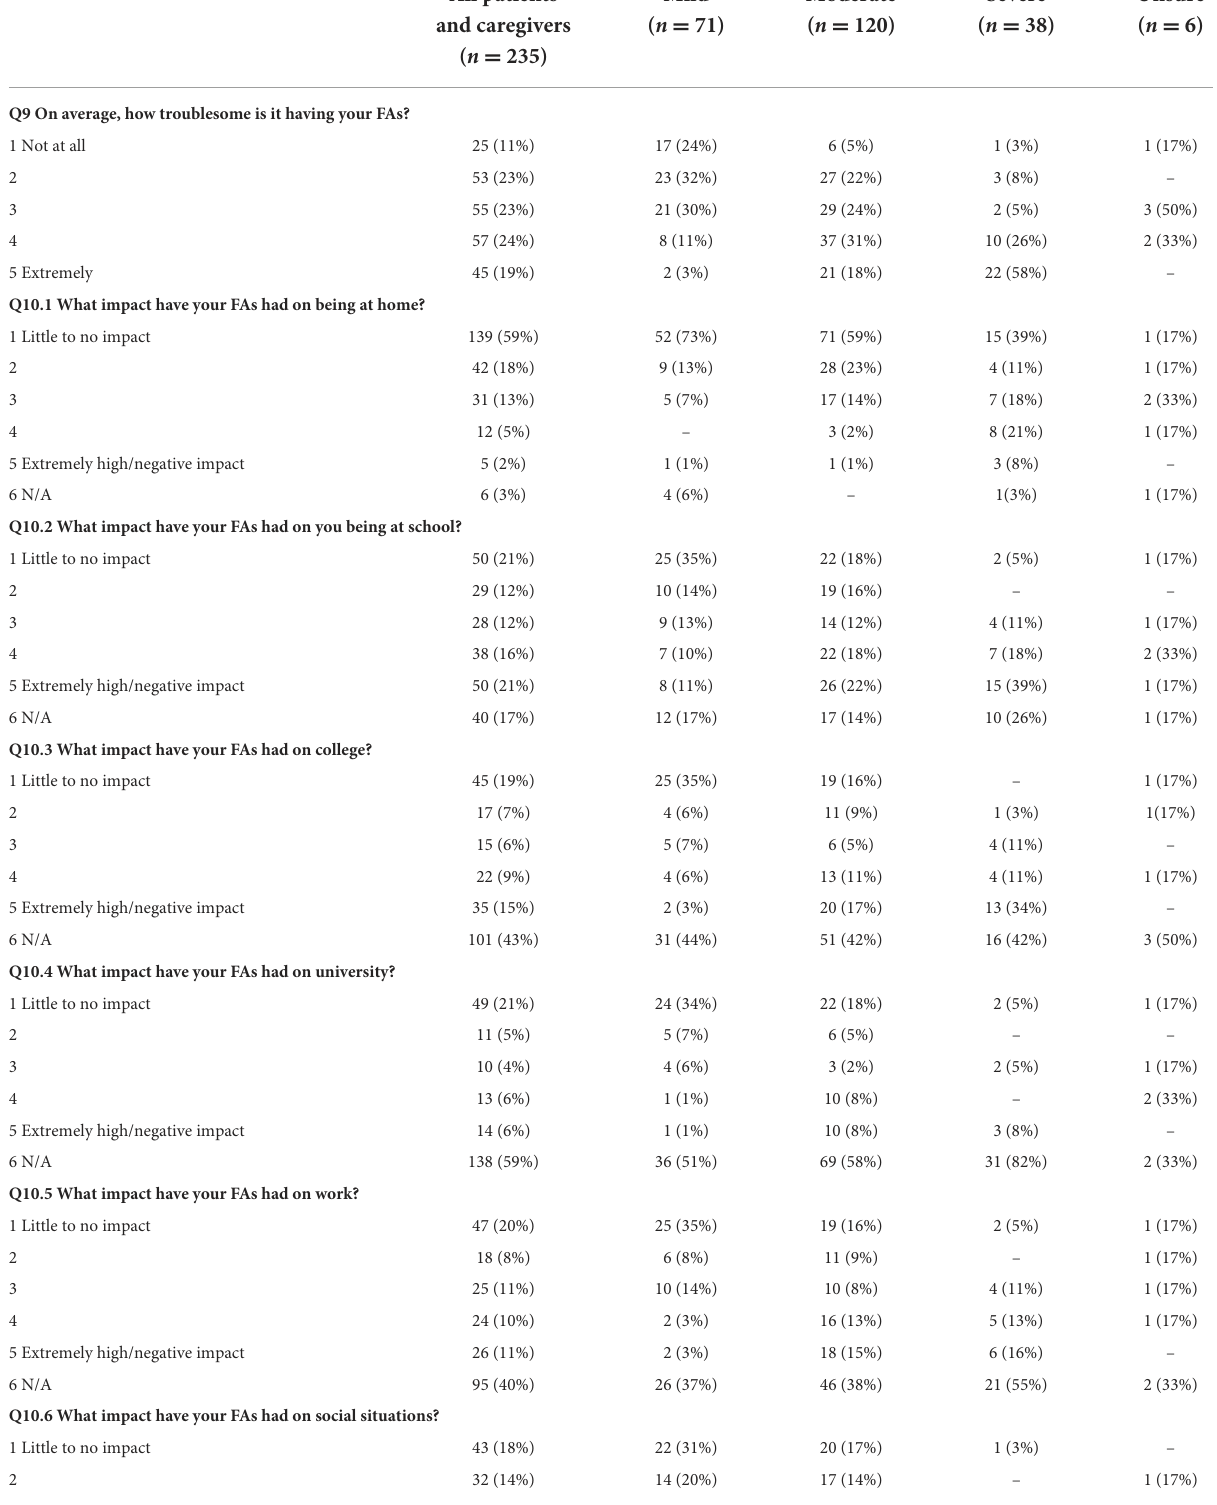
How severe would you say your FAs